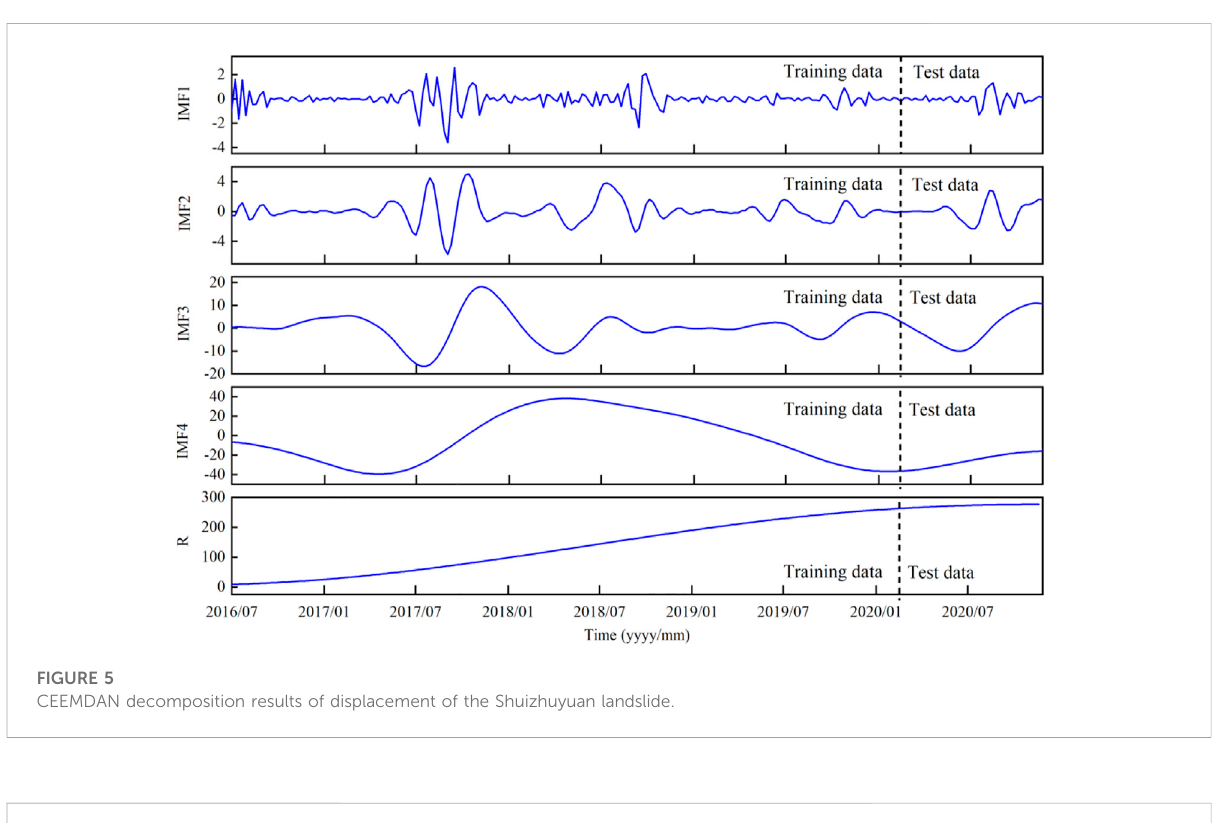
FIGURE 5 CEEMDAN decomposition results of displacement of the Shuizhuyuan landslide.